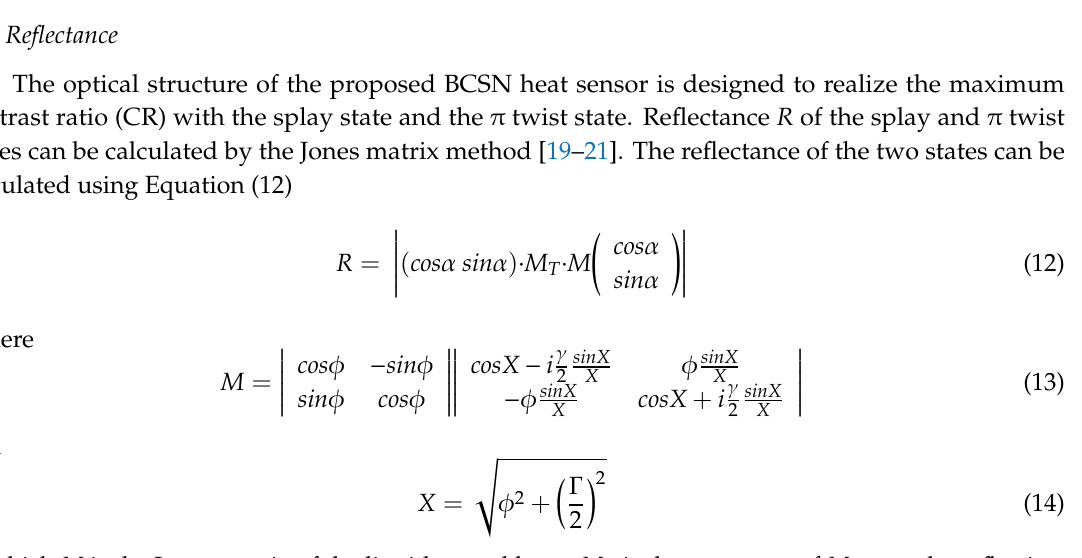
Figure 5. Optical structure of the reflective BCSN mode. The transmission axis of the polarizer and the rubbing direction of the liquid crystal cell are intersected by 45° so that a dark state could be obtained at the splay state.